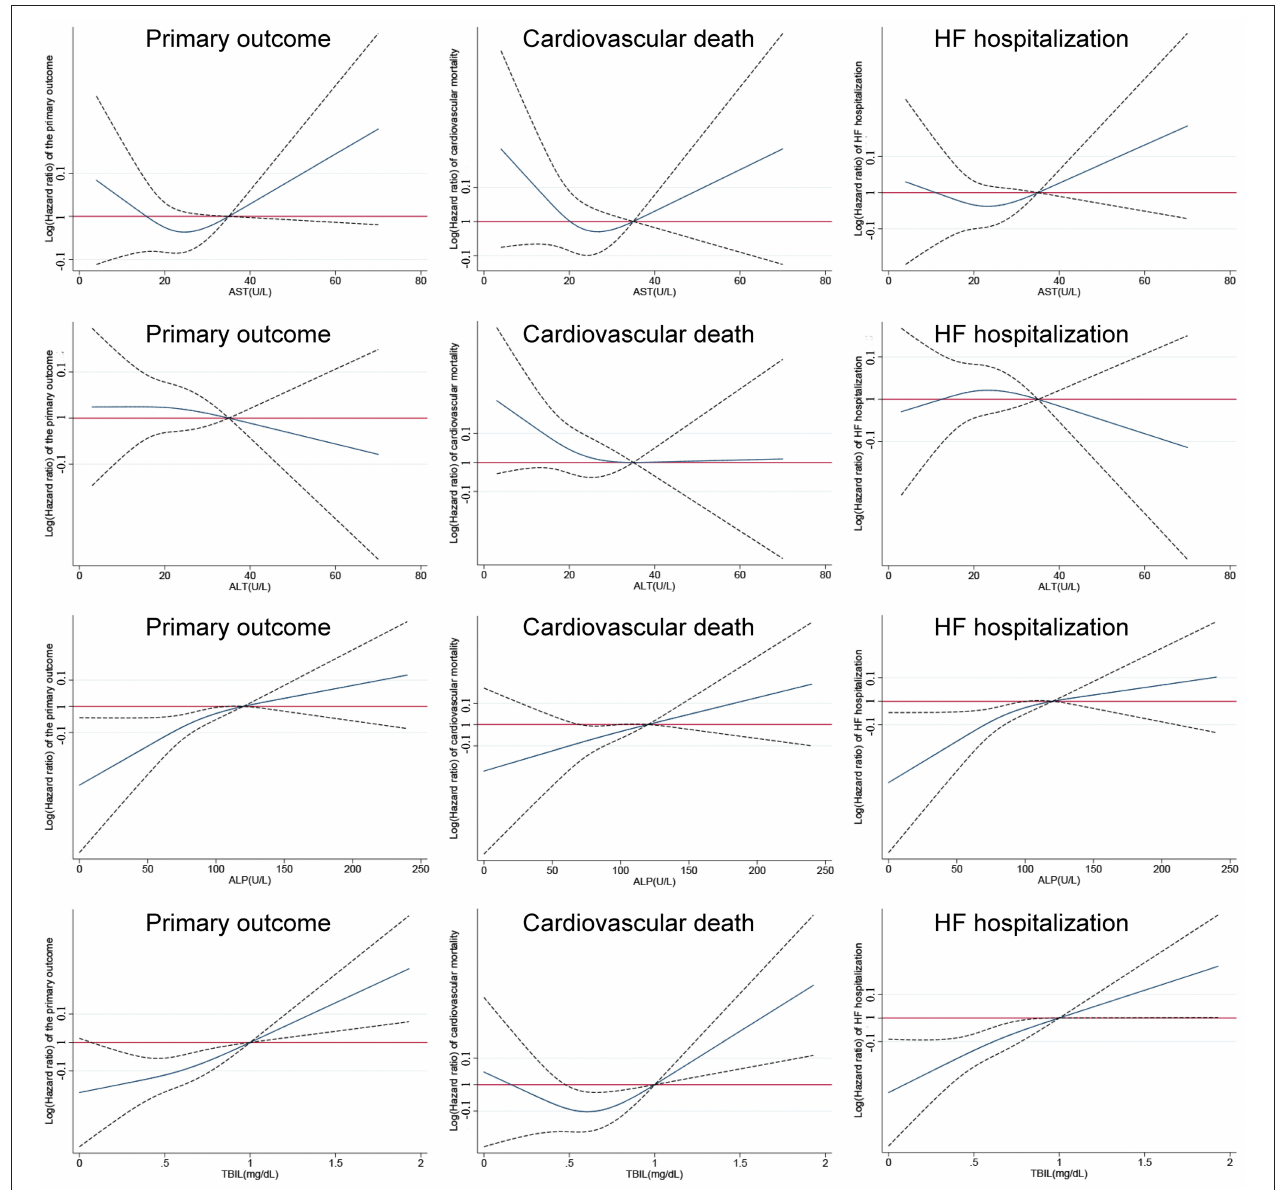
FIGURE 2 | Restricted cubic remodeling of Cox proportional hazards models of aspartate transaminase (AST), alanine transaminase (ALT), total bilirubin (TBIL), and alkaline phosphatase (ALP) to primary and secondary outcomes (solid lines represent relative hazard ratios; dot lines represent upper and lower limits of 95% confidence